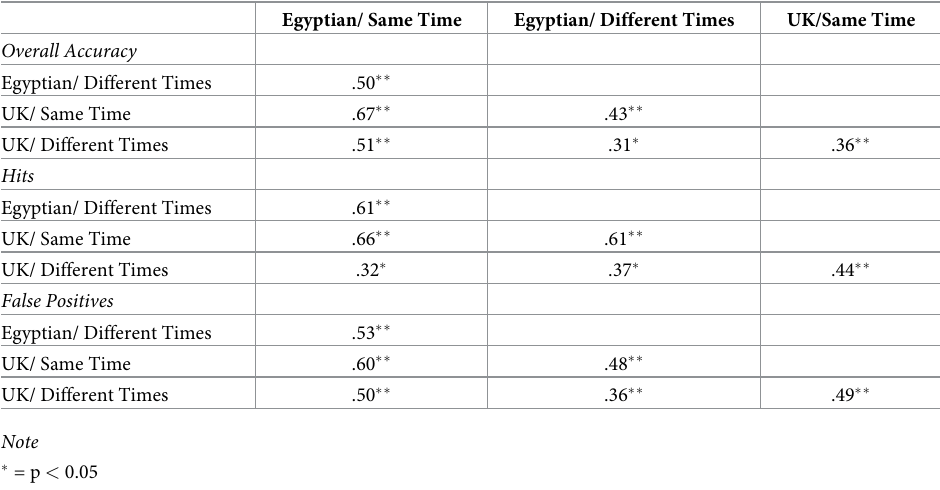
1 reported that higher levels of expressive suppression, but not cognitive reappraisal, were asso- ciated with a lower level of overall face-memory accuracy and higher rates of misidentifications Table 8. Correlations among the four face-matching tasks in Experiment